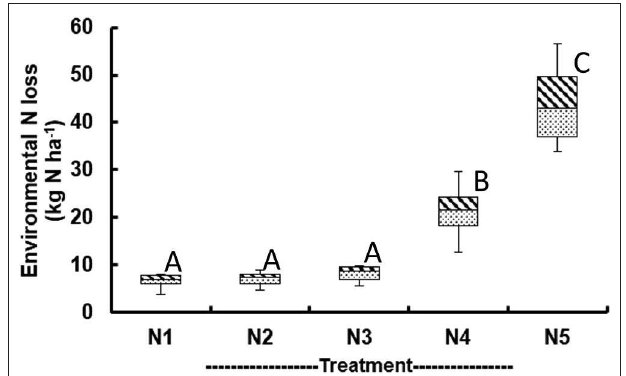
FIGURE 1 | Crop yield in the five nitrogen rate treatments during 2009–2018. In all the treatments, 30kg N ha − 1 was applied at planting and rest was sidedressed in the growing season. Total N rates in five treatments were as follows: N1: 30kg N ha − 1 ; N2: 57kg N ha − 1 ; N3: 87kg N ha − 1 ; N4: 145kg N ha − 1 ; N5: 218kg N ha − 1 . Treatments indicated by letters are significantly different from each other with a p -value of 0.05 based on a Tukey HSD (Honestly Significant Difference).